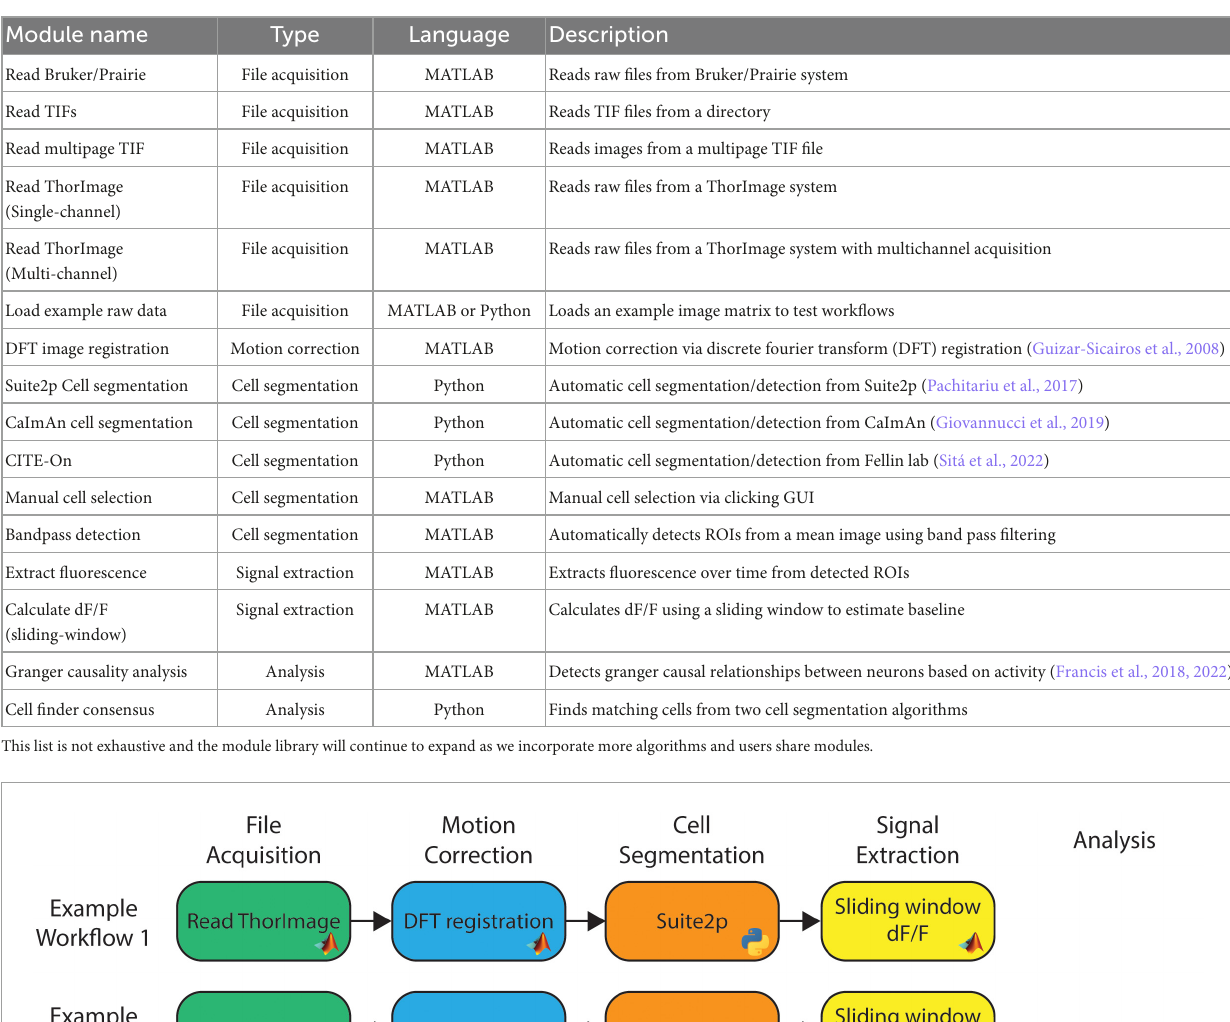
TABLE 1 Highlighted modules included in